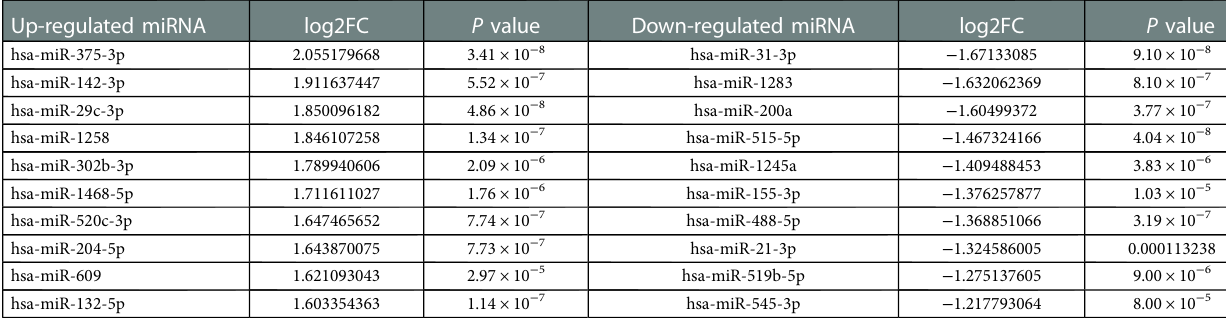
TABLE 5 Top 10 DmiREs from